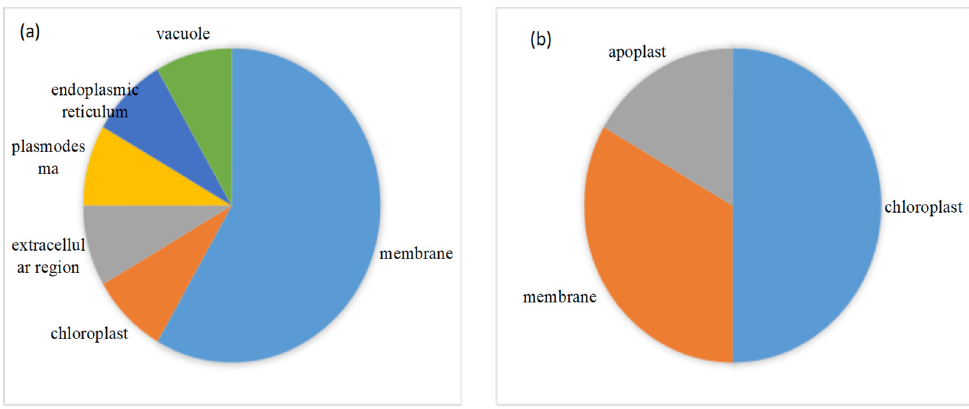
Figure 7. Subcellular location of function unknown up-regulated DEPs ( a ) and down-regulated DEPs ( b ).